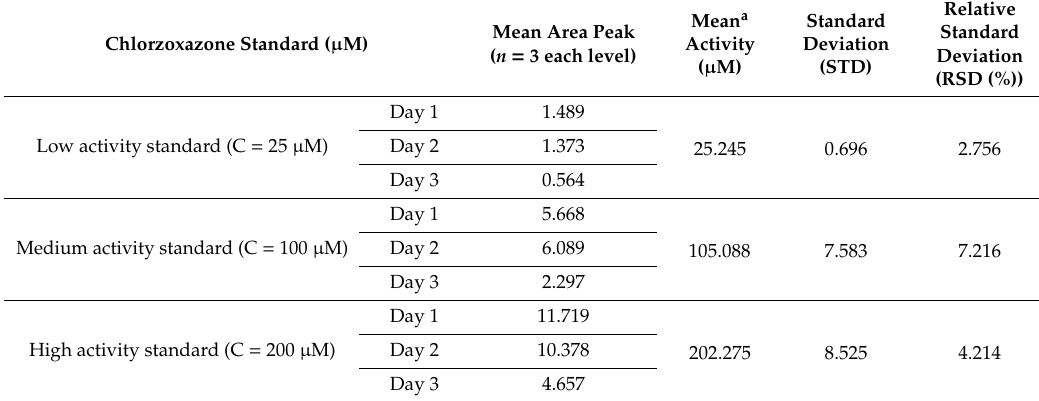
Table 5. Inter-assay variation for chlorzoxazone.